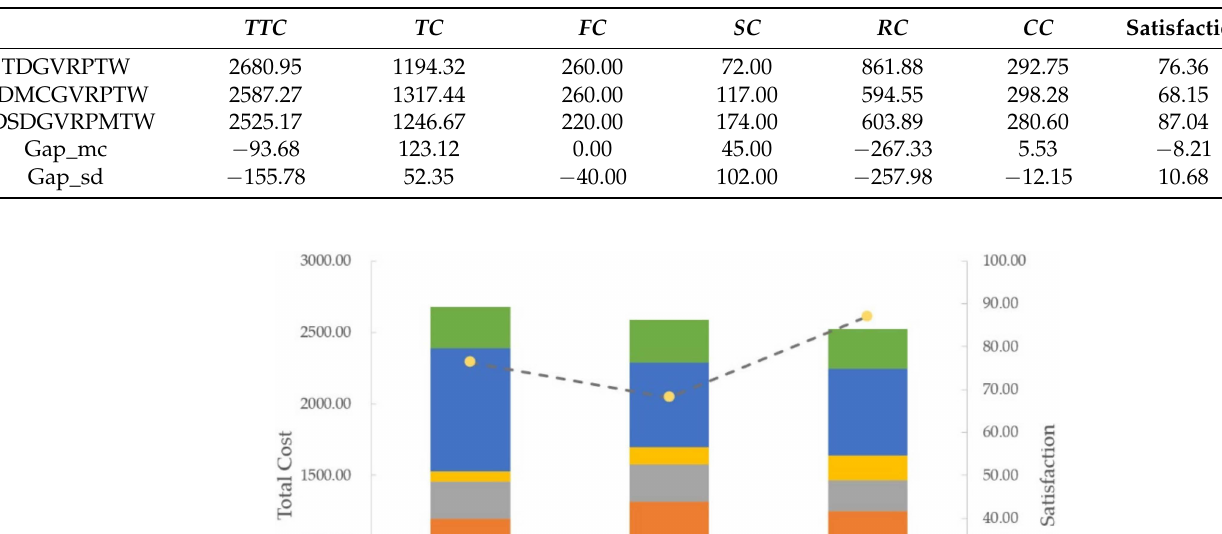
Table 7. Comparison of three delivery strategies.